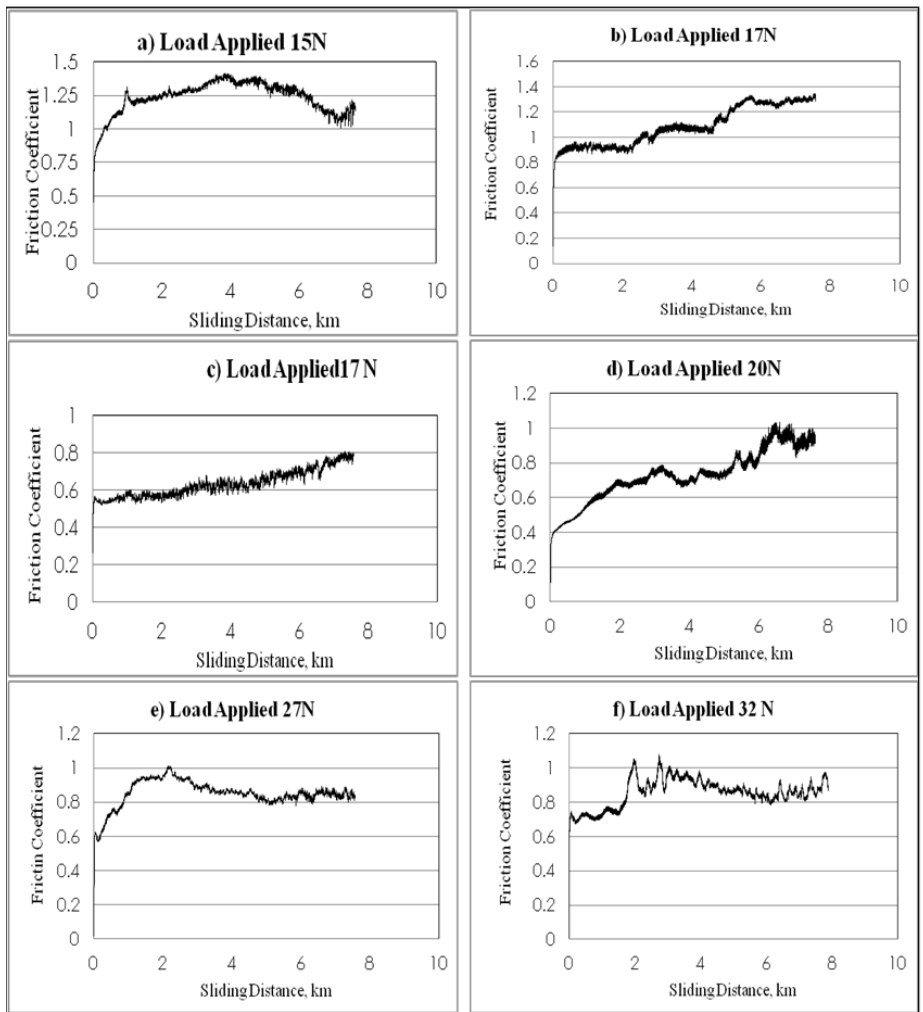
Figure 8. Frictional coefficient of neat epoxy v. sliding distance at different loads and speeds.